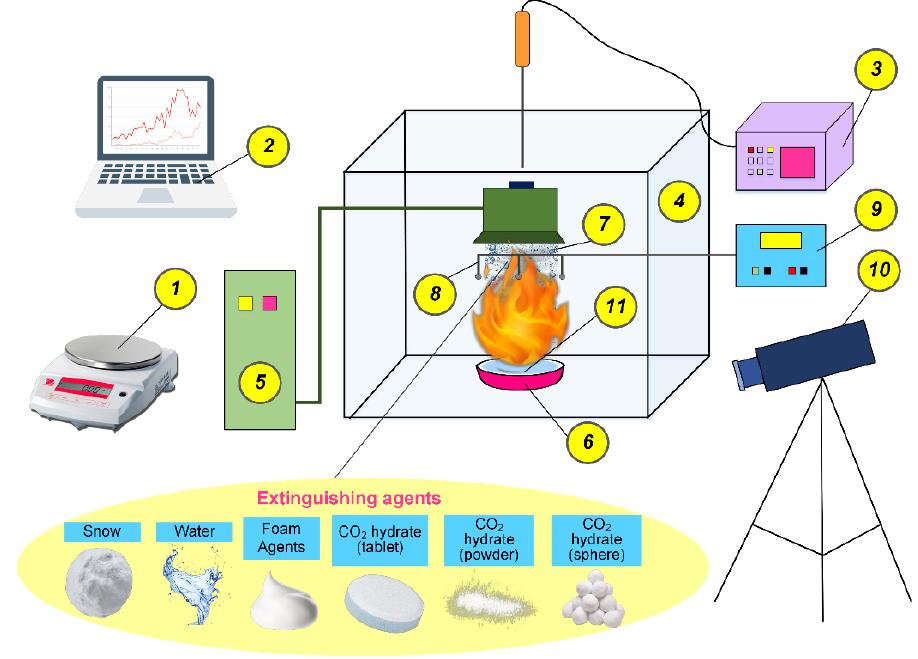
Figure 1. Scheme of setup: 1—electronic balance; 2—laptop; 3—gas analyzer; 4—transparent cube; 5—extinguishing agent feeder; 6—container with a burning liquid; 7—extinguishing agent; 8—thermocouple; 9—temperature transmitter; 10—camera; 11—flammable liquid.